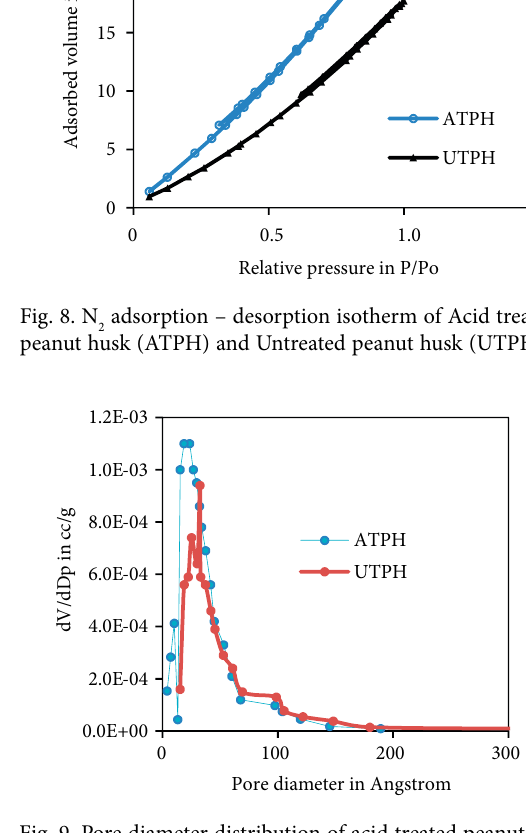
Table 1. Comparison of activating agents used for chemical activation of various adsorbent (Low et al. 1995; Acar, Eren 2006; Ngah, Hanafiah 2008; Baccara et al. 2009; Dubey, Gopal 2007; Li et al. 2007; Shukla, Pai 2005)